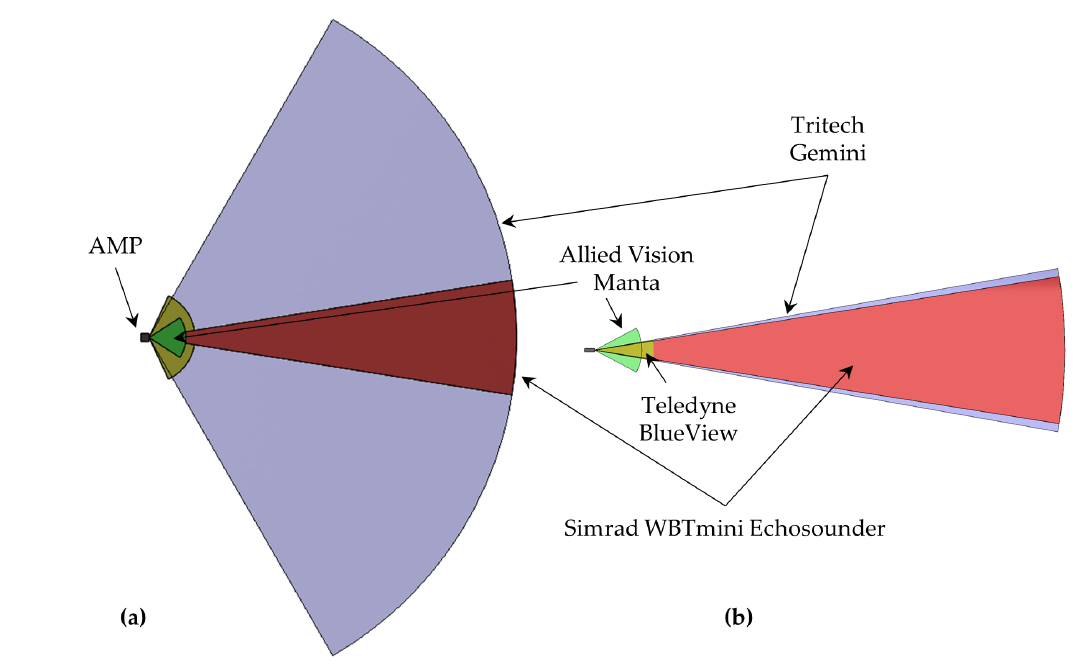
Figure 2. AMP sensor field of view for a horizontally oriented deployment showing the AMP body to scale for ( a ) top-view and ( b ) side-view with the Manta optical cameras to 8 m (nominal range), BlueView sonar to 10 m, Gemini sonar to 80 m, and Simrad echosounder to 80